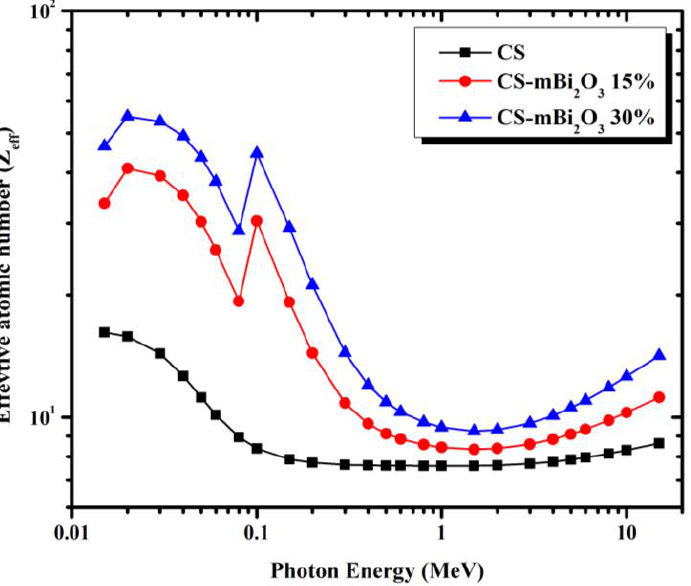
Figure 8. Variation of the effective atomic number (Z eff ) of mortar samples as a function of energy.